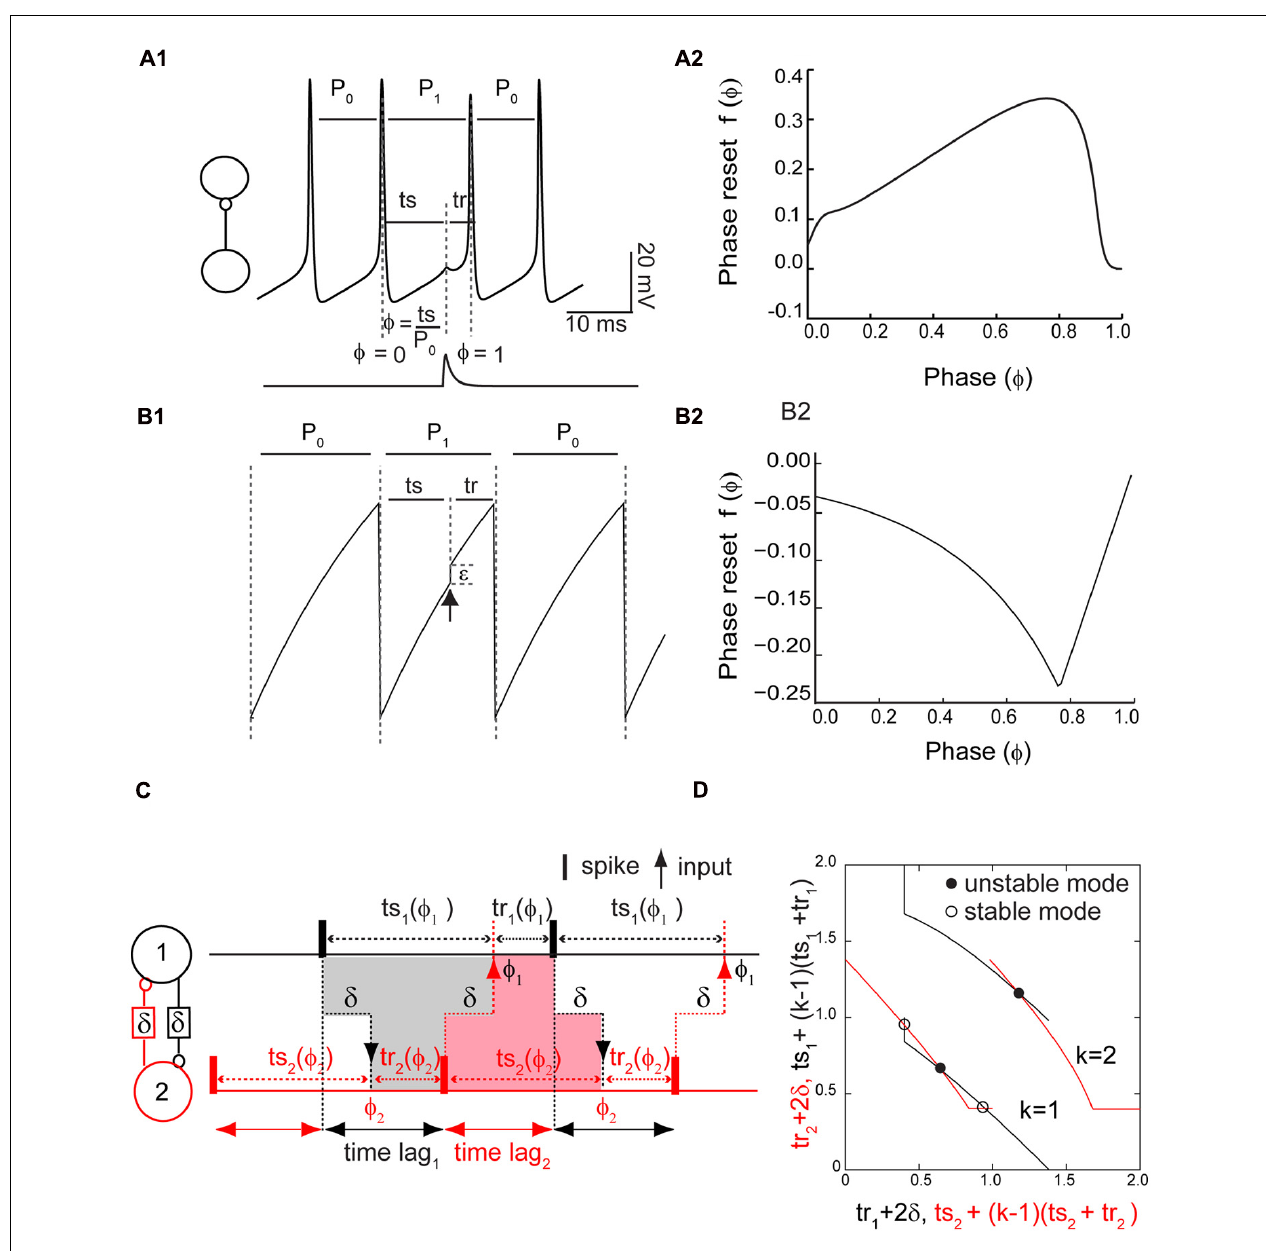
FIGURE 1 | Phase response curve (PRC) measured in isolated neurons and used to predict network activity. (A1) PRC measurement in a Wang–Buzsaki model neuron. Inset shows open loop configuration without feedback. A perturbation in the form of a synaptic conductance waveform evoked by a single spike in the presynaptic neuron (lower trace) is applied at a phase of φ = t s/ P 0 , and the phase resetting f ( φ ) is the normalized change in cycle length f ( φ ) = ( P 1 − P 0 )/ P 0 . Alternatively, the perturbed cycle length P 1 is equal to the sum of the stimulus ( t s) and recovery ( t r) intervals. (A2) Typical PRC for an inhibitory input to aWang–Buzsaki neuron with g syn = 0.35 mS/cm 2 , τ syn = 1 ms, I stim = 2.0 μ A/cm 2 , and otherwise as the Methods. (B1) PRC measurement in a leaky integrate and fire model neuron. An instantaneous increment in membrane potential (black arrow) either advances the phase or immediately causes the neuron to reach threshold. (B2) Typical PRC for leaky integrate and fire neuron. Beyond a phase of about 0.8, a spike is triggered immediately by the input. In this “causal limit” region,